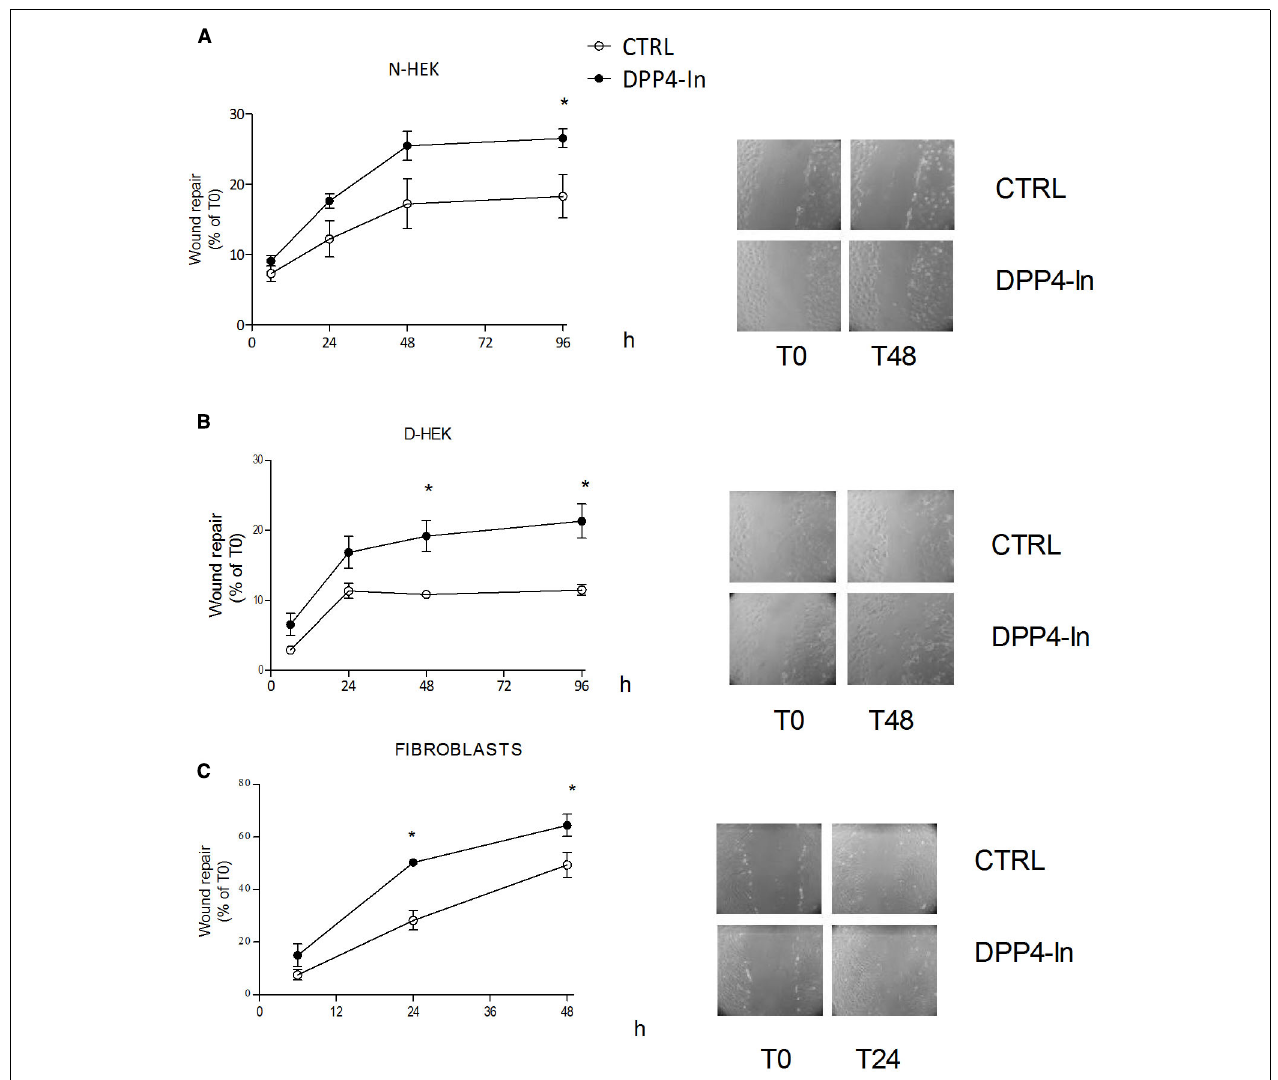
FIGURE 5 | Inhibition of DPP4 increases scratch repair in different cell types. Treatment with DPP4-In (10 m M) enhances wound repair in normal human keratinocytes (N-HEK) (A) , keratinocytes from diabetic patients (D-HEK) (B) and fibroblasts from healthy human skin (C) . In (A) and (B) ,